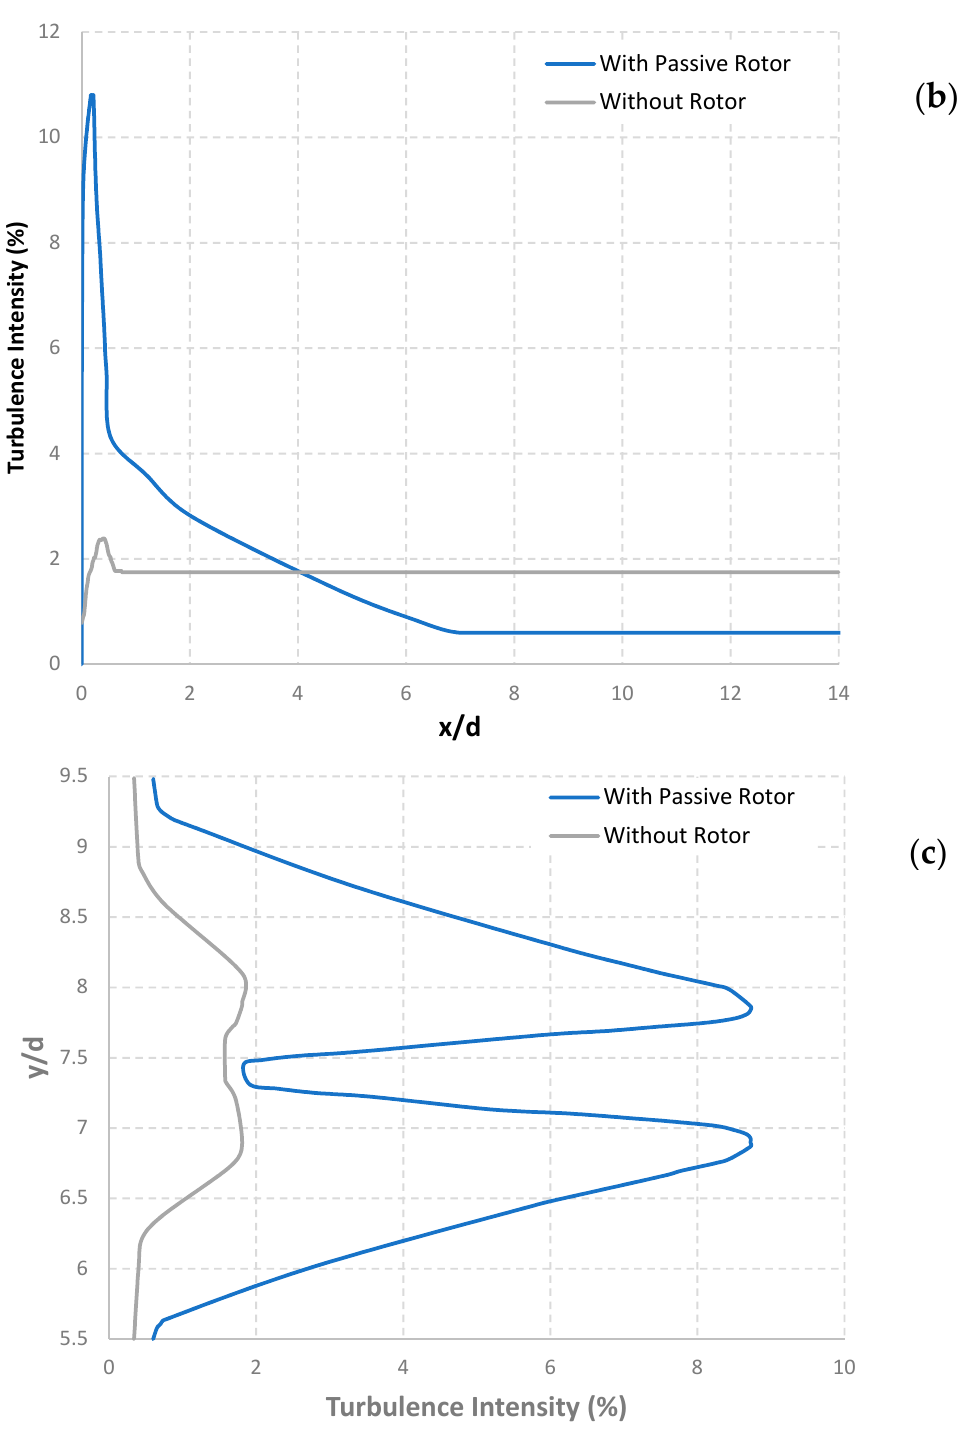
Figure 15. Effect of the passive rotor on the turbulence intensity at υ av =30 cm/s and ω = 293.5 rpm. ( a ) Color contour map (vertical plan) of the turbulence intensity downstream of the rotor. ( b ) Spatial variations in turbulent intensity along the x-x transect. ( c ) Spatial variation of TI along the y-y tran- sect.